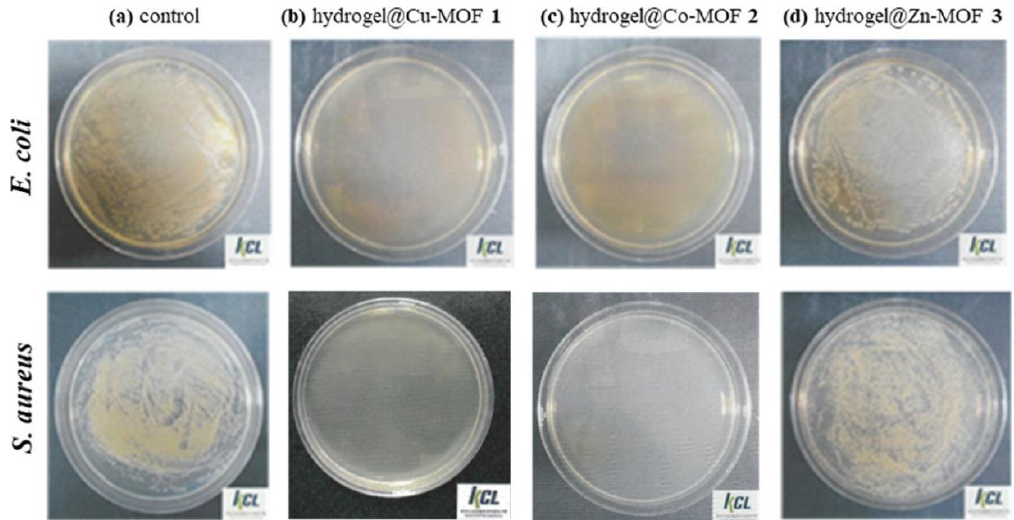
Figure 8. Assessment of antibacterial effects after 24 h of incubation by colony-forming assay on different metal–organic frameworks (MOFs)-encapScheme 105. cfu mL − 1 ). Reprinted with permission from ACS Appl. Mater. Interfaces 2020, 12, 20234 − 20242. Copyright 2020, American Chemical Society